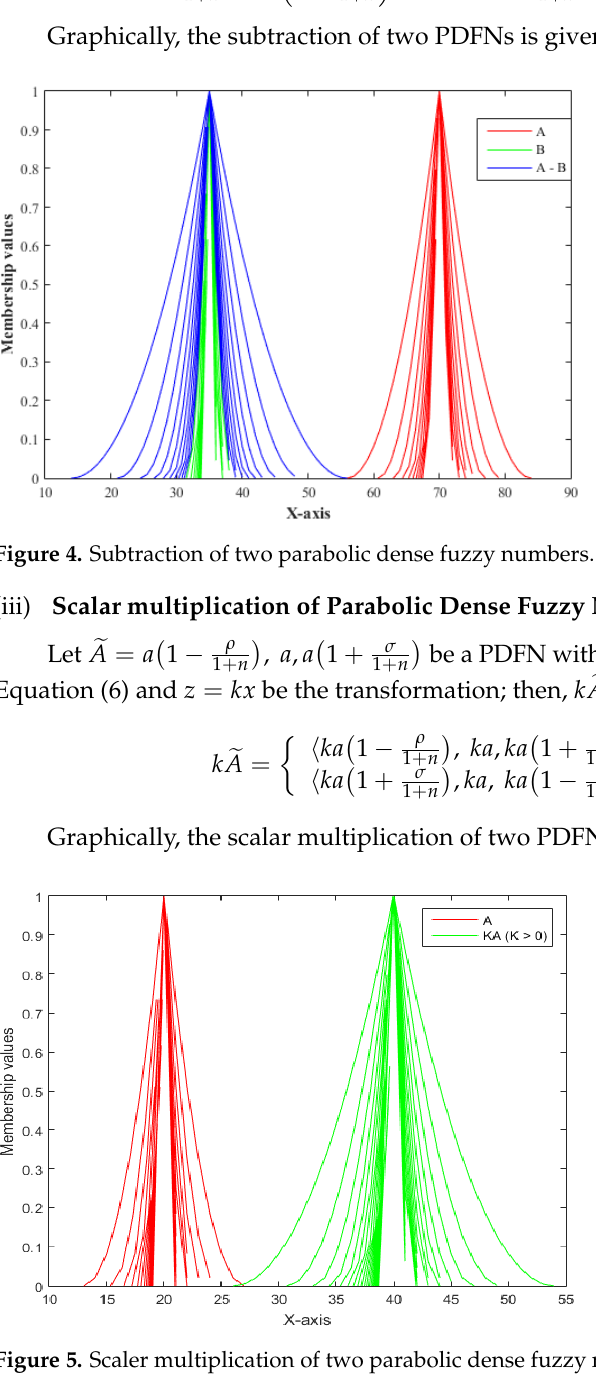
Figure 5. Scaler multiplication of two parabolic dense fuzzy numbers.